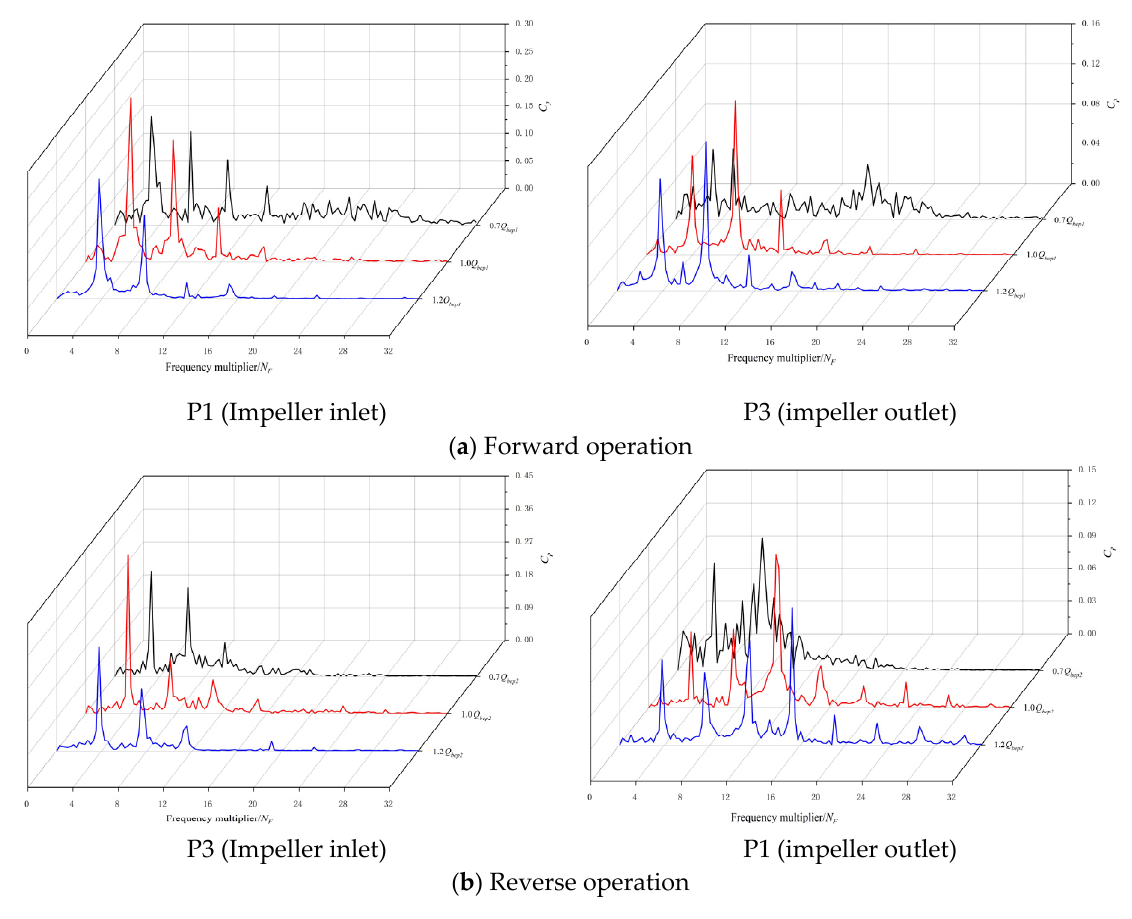
Figure 18. Pressure pulsation distribution of monitoring points P1 and P3 in pump under different operating conditions.